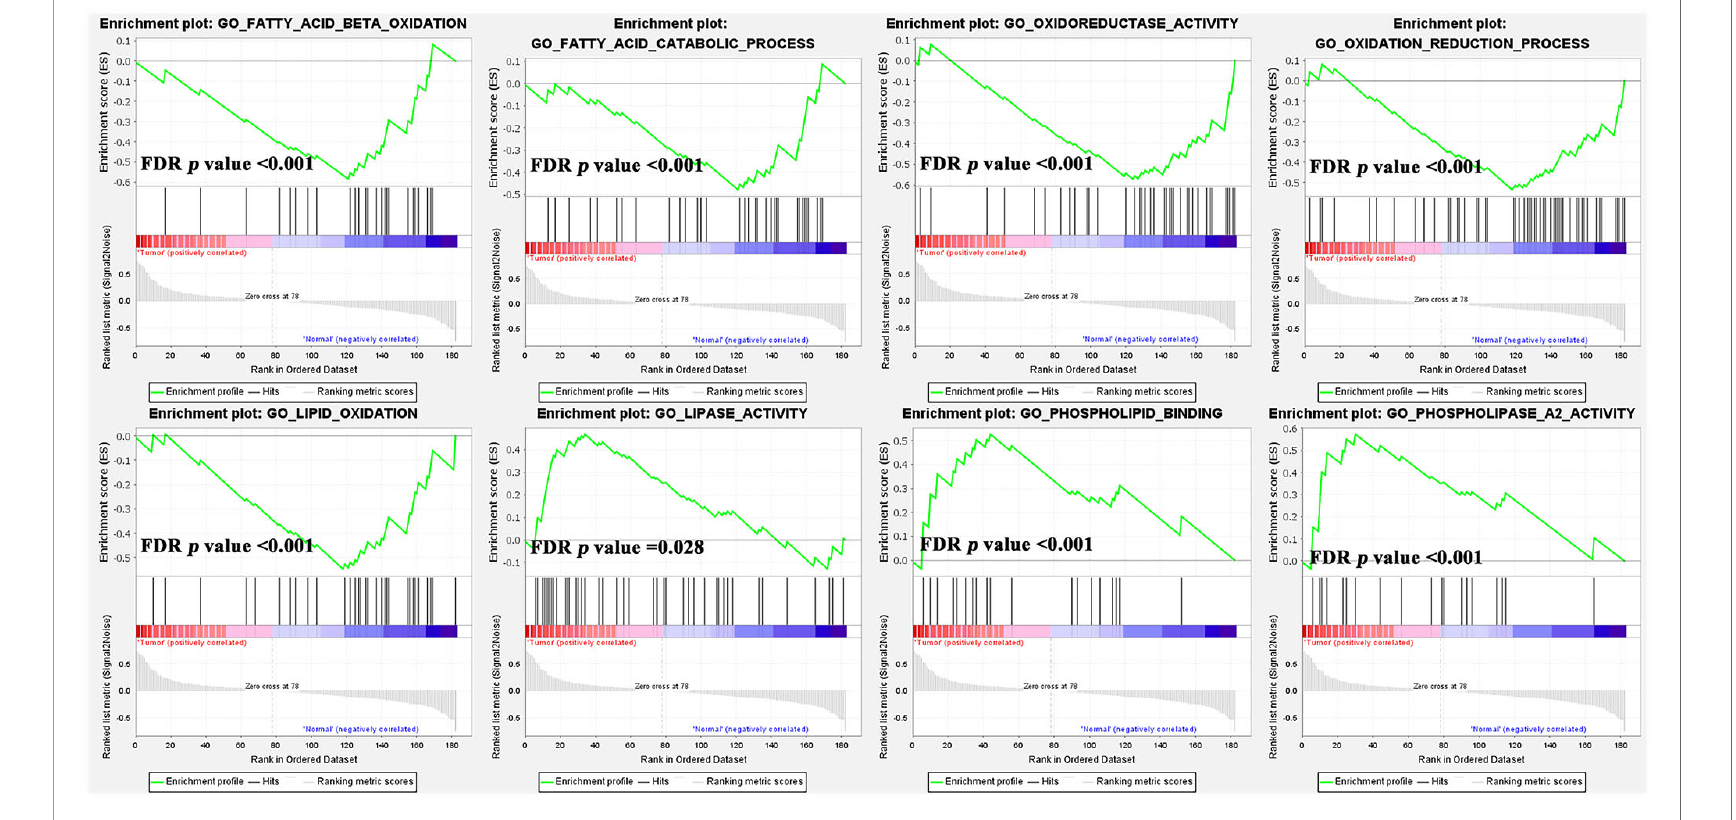
FIGURE 7 | The gene set enrichment analysis (GSEA) analysis of GO terms of lipid metabolism in GC rather than normal